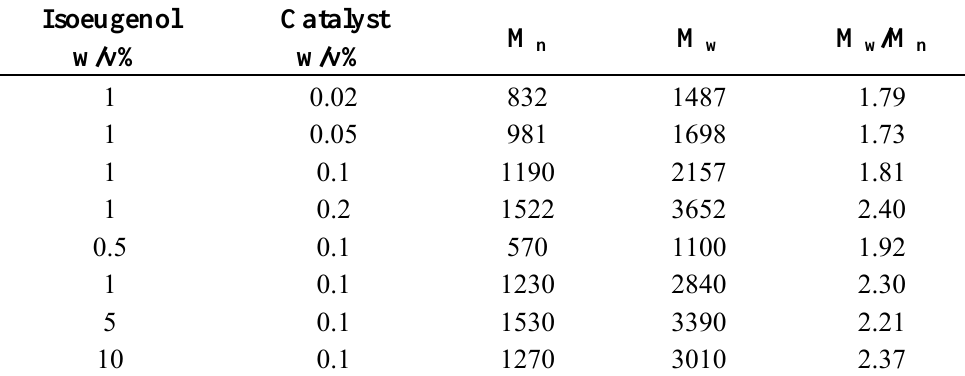
Table 4. Results of GPC analyses on coupling products of isoeugenol with CuSS at different concentrations of catalyst and